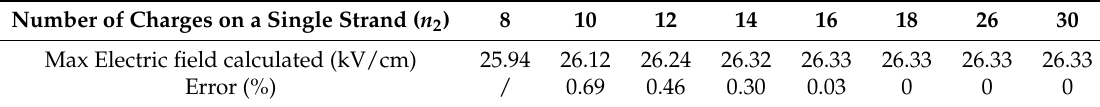
Table 7. Computation error: change in electric field with number of charges on a single strand.